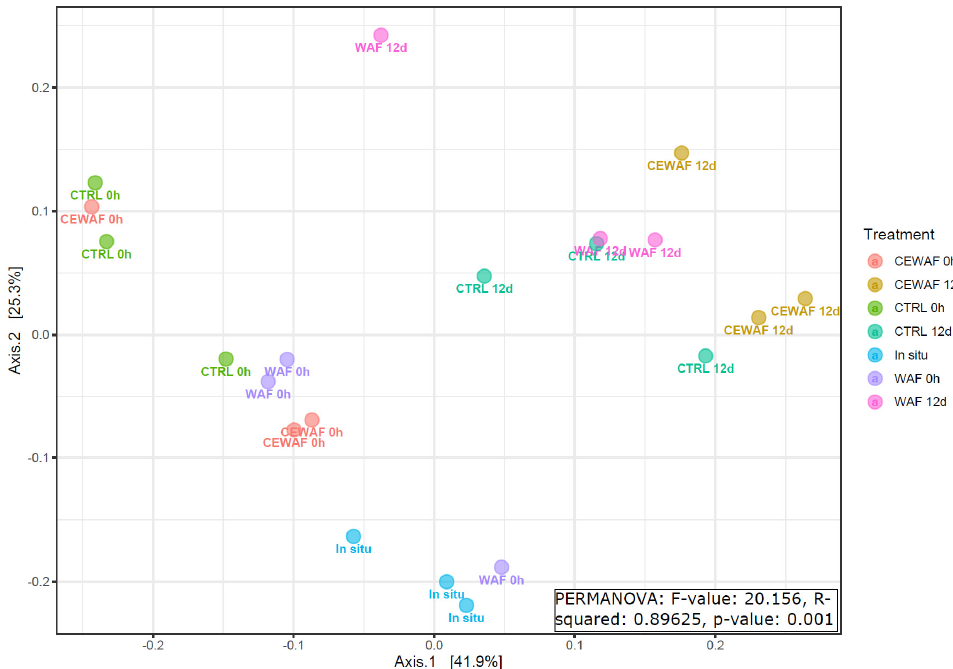
Figure 8. PCoA of microbial communities at the genus level in the Gulf of Bothnia experiment. PCoA was based on a Bray–Curtis distance matrix using genera data.